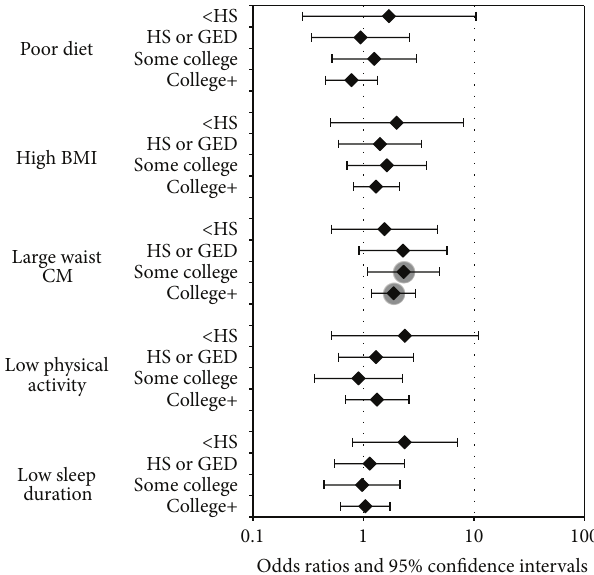
Figure 2: Odds ratio estimates for prediabetes or insulin resistance by education strata.